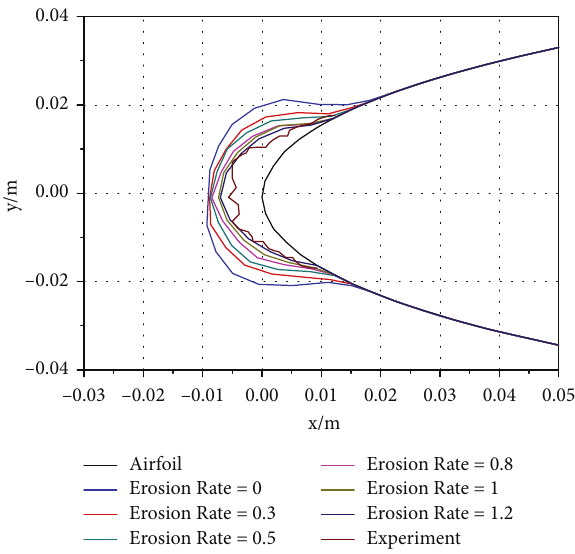
Figure 6: Comparison of ice shapes for di ff erent erosion